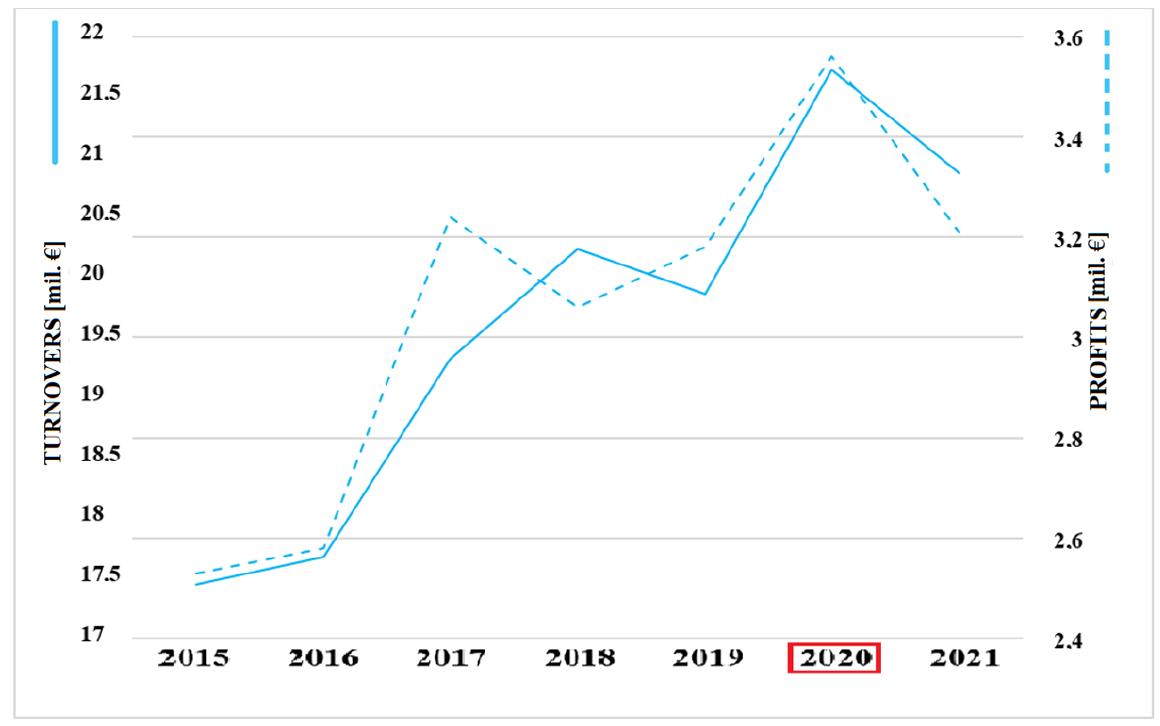
Figure 3. Development of profit and turnovers of the largest wine company in Slovakia [56].